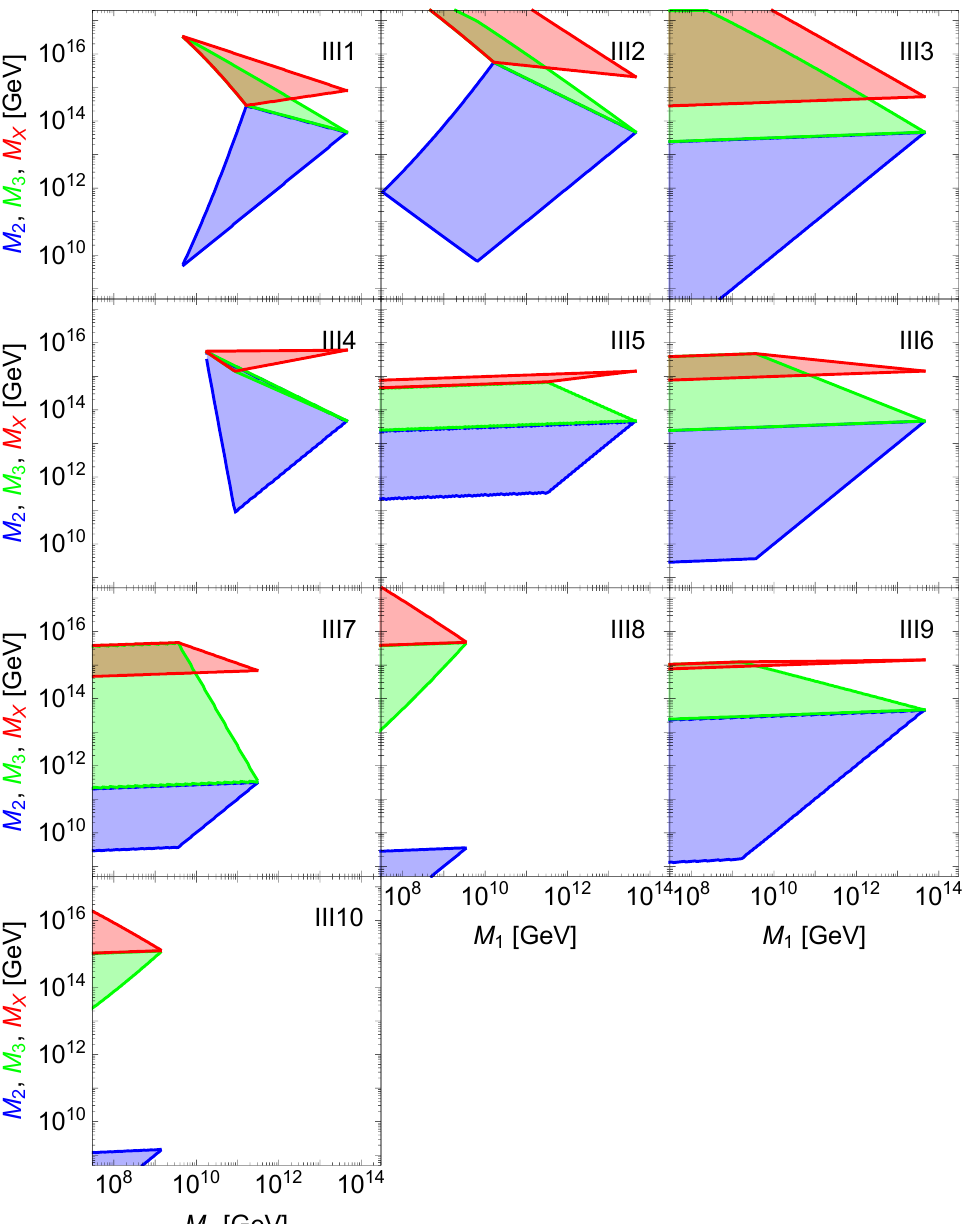
Figure 2 . Prediction of GUT scale, M X , and intermediate scales M 1 , M 2 and M 3 , in type (c) breaking chains with three intermediate scales SO(10) M X −−→ G energy scale ordering M